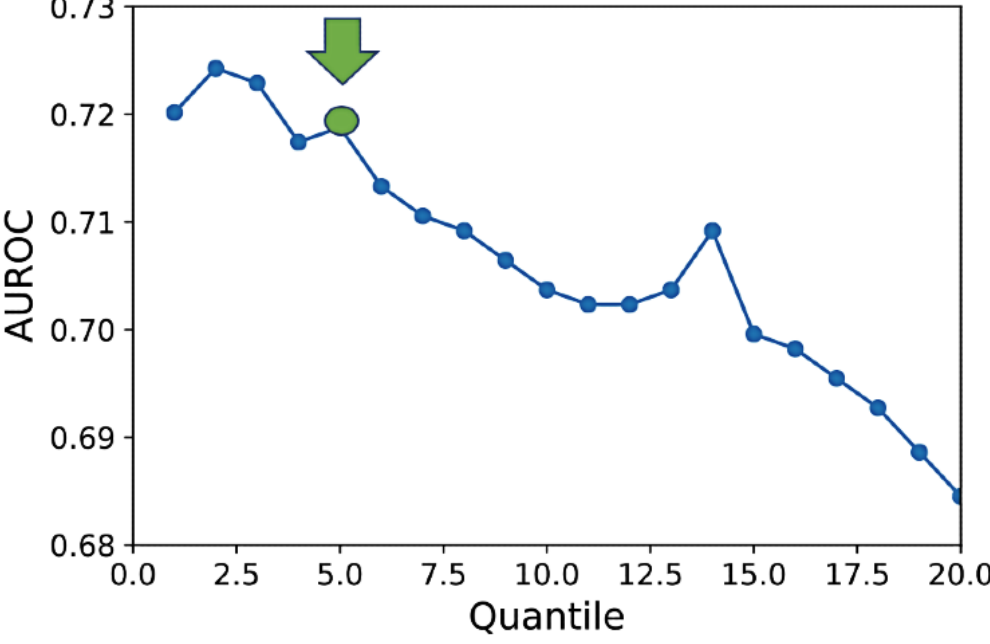
Figure 4. Test set AUROC (PD vs Control) as a function of the chosen video distribution quantile to use as the “Q” threshold. A wide range of quantiles achieves AUROC > 0.7 (15th quantile and below). The fifth quantile, selected as our video score threshold, is shown in green. AUROC: area under the receiver operating characteristic curve; PD: Parkinson